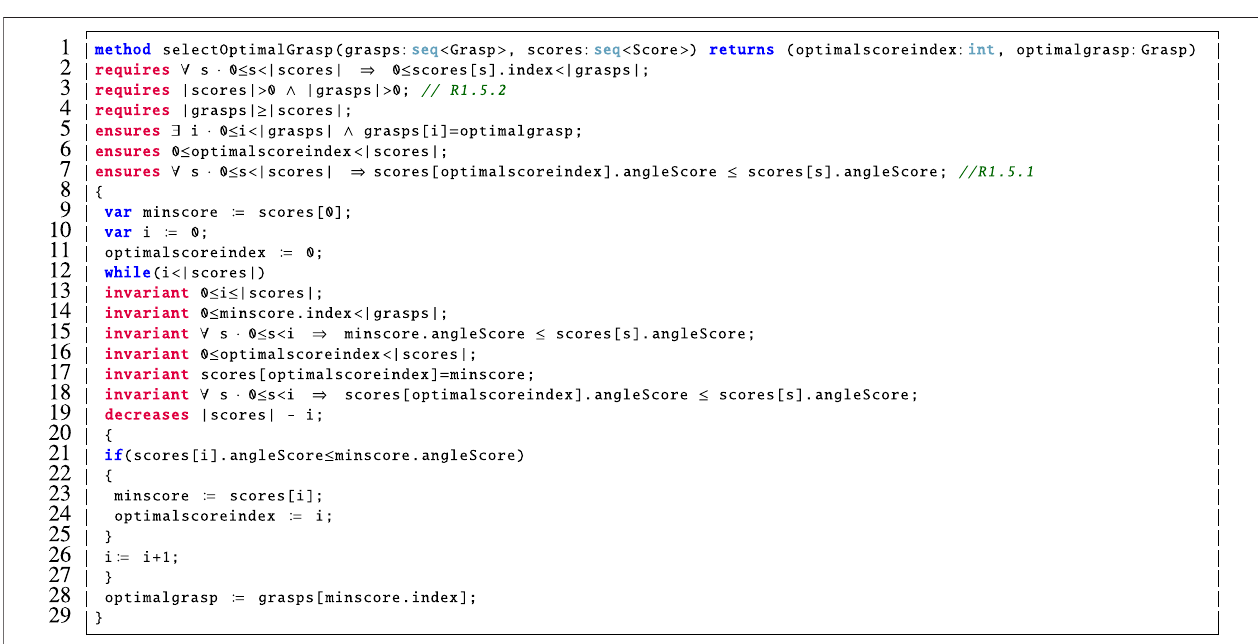
FIGURE 9 | Dafny encoding of the selectOptimalGrasp